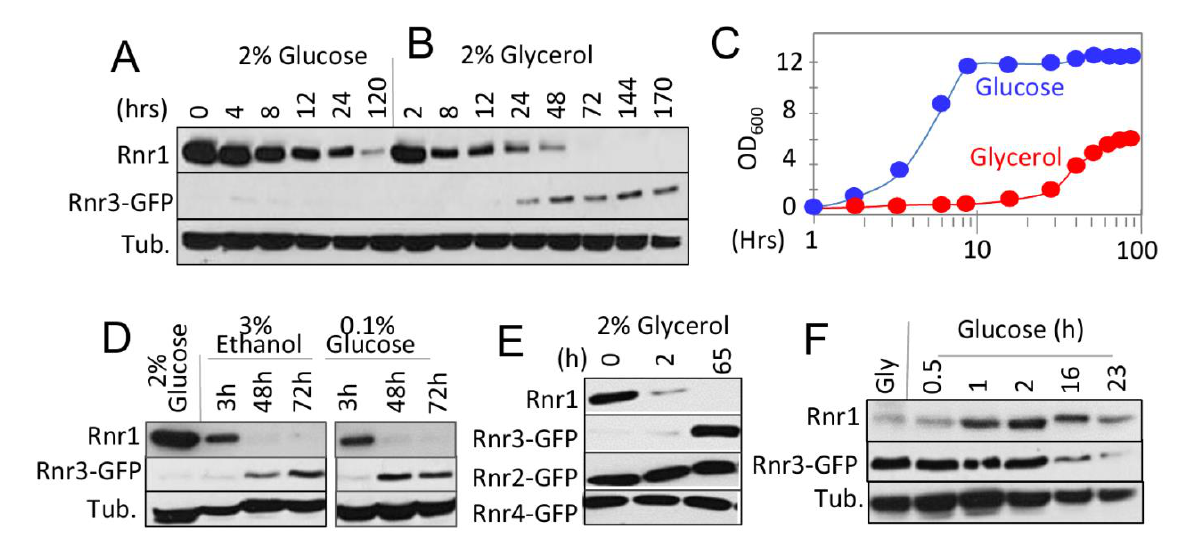
FIGURE 1: Impact of carbon source on the steady state levels of Rnr1 and Rnr3. (A, B ) RNR3-GFP cells were grown to mid-log phase in synthetic complete medium supplemented with 2% glucose (SCD). The cells were collected and released into either SCD (A) or SC medium supplemented with 2% glycerol (SCG; B) for further incubation. Whole cell extract (WCE) samples were prepared at the indicated time points and subjected to Western blot analysis using  -Rnr1 and  -GFP antibodies. Tubulin was used as a loading control. (C) OD 600 of the SCD (blue) and SCG (red) cultures in panels A and B at the indicated time points. (D) RNR3-GFP cells were grown to mid-log phase in